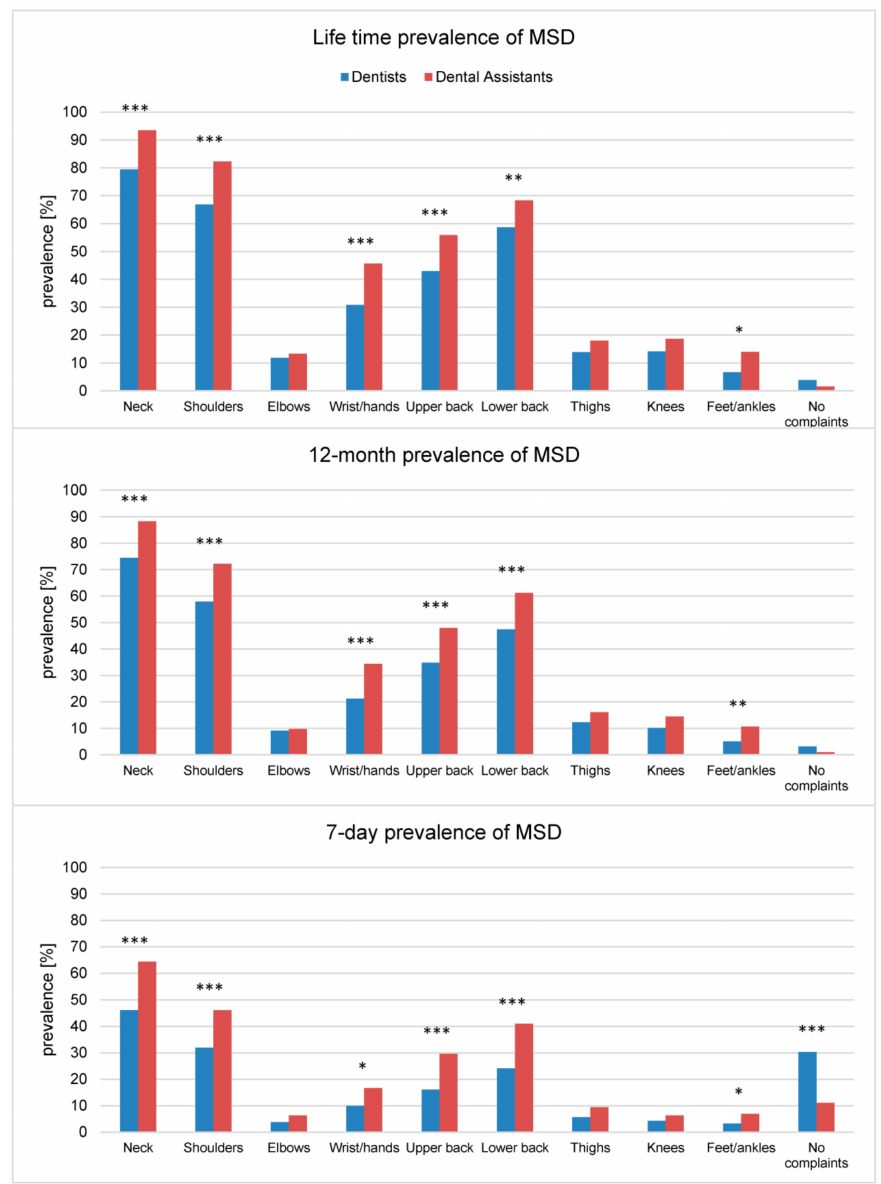
Figure 1. Lifetime prevalence, 12-month prevalence and 7-day prevalence of MSD among dentists and dental assistants. Significant differences between dentists and dental assistants are marked with asterisks: p < 0.05 = *; p < 0.01 = **; p < 0.001 =